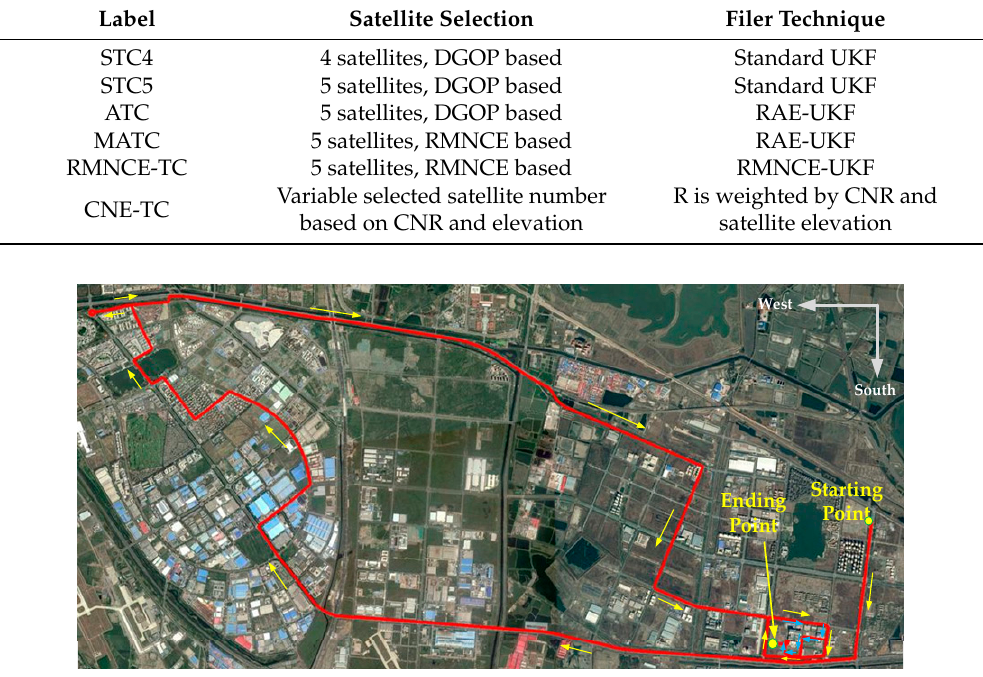
Figure 11. Reference trajectory of the field experiment (the blue arrows indicate the final part).